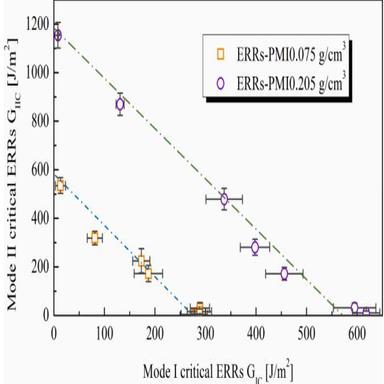
Comparison of the critical energy release rates of the PMI foams with density of 0.075 and 0.205 g/cm3 under mixed mode fracture. Decoupled critical mode I and II energy release rates (ERRs) were plotted in the coordinate system so that the relationship between critical mode I and II ERRs as well as the density effect could be visually observed.